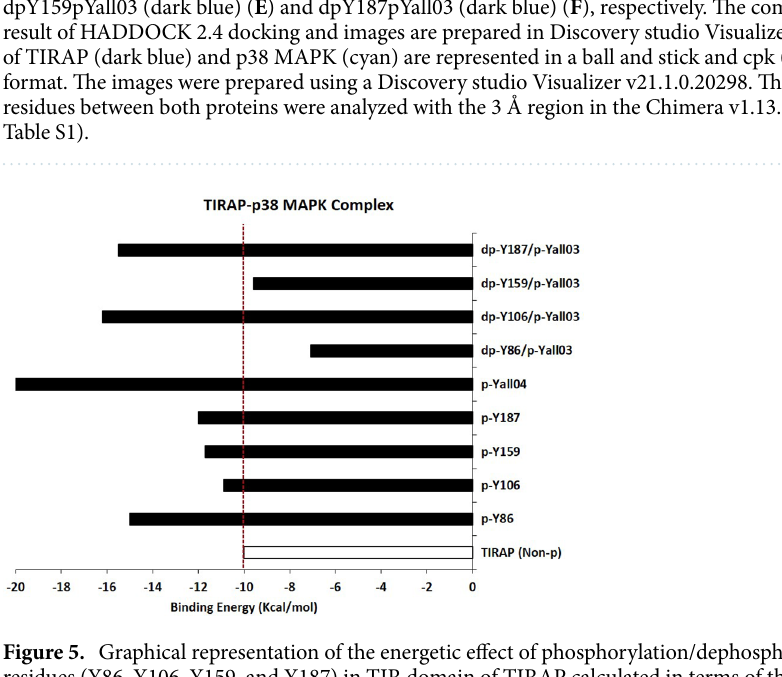
Figure 5. Graphical representation of the energetic effect of phosphorylation/dephosphorylation of tyrosine residues (Y86, Y106, Y159, and Y187) in TIR domain of TIRAP calculated in terms of the change in the free binding energy (BE) of TIRAP and p38 MAPK complexes. The changes in BE of phosphorylated tyrosine TIRAP and p38 MAPK complexes are compared with that for the non-phosphorylated TIRAP and p38 MAPK complex while the significance of each tyrosine residue by sequential dephosphorylation is compared with the complex of all four phosphorylated tyrosine TIRAP and p38 MAPK